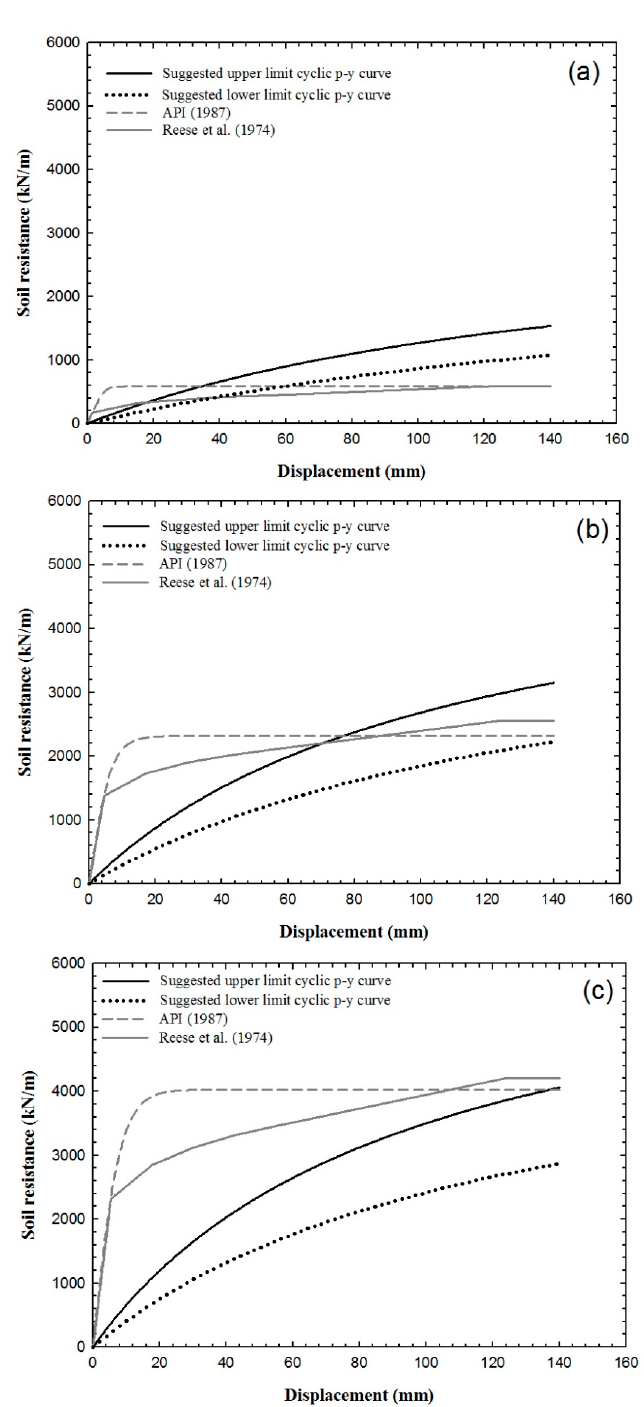
Figure 20. Suggested cyclic p-y curve at a depth of 7